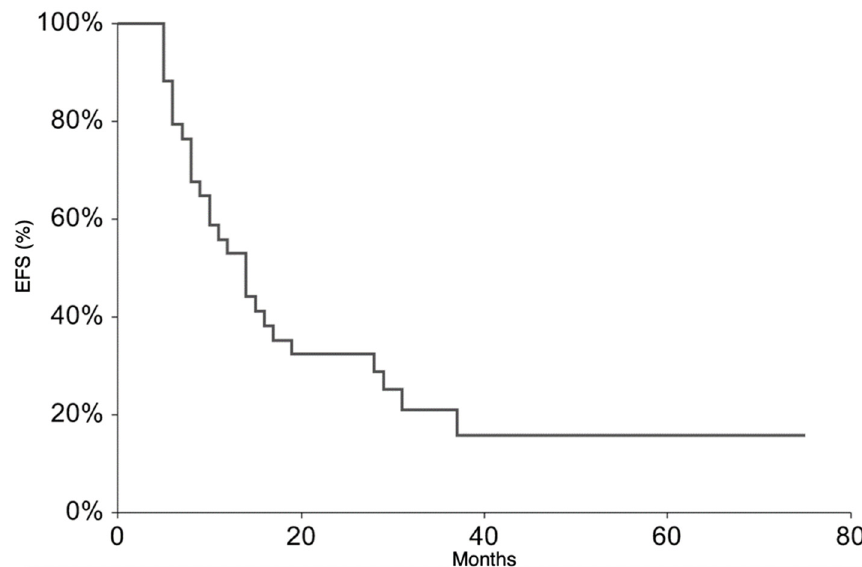
Figure 1. Event-Free Survival for the whole patient group.